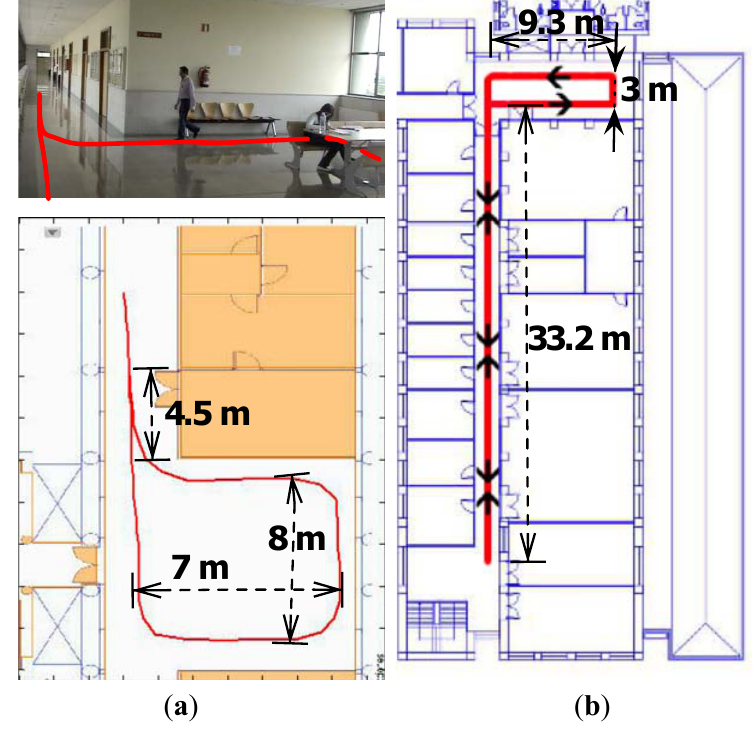
Figure 4. Short-range indoor experiments. ( a ) Location A, a closed path 39 meters long and 360 degrees turns, real-time results of one experiment; ( b ) Location B, a closed path 91 meters long with 360 degrees